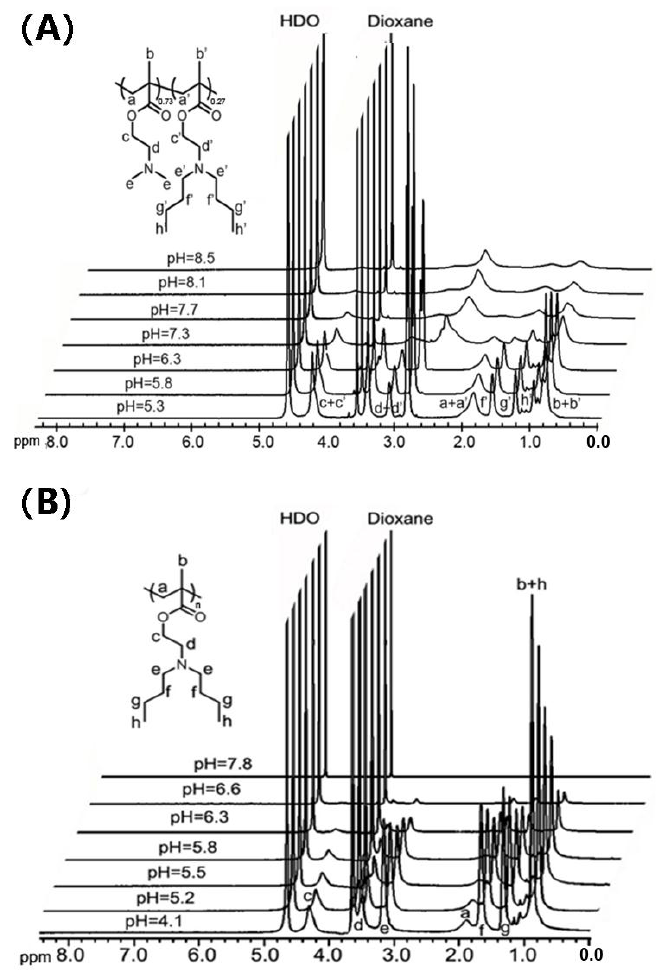
Figure 4. 1 H-NMR spectra of ( A ) P(DMAEMA 0.73 - co -DBAEMA 0.27 ) and ( B ) PDBAEMA at different pH in D 2 O.